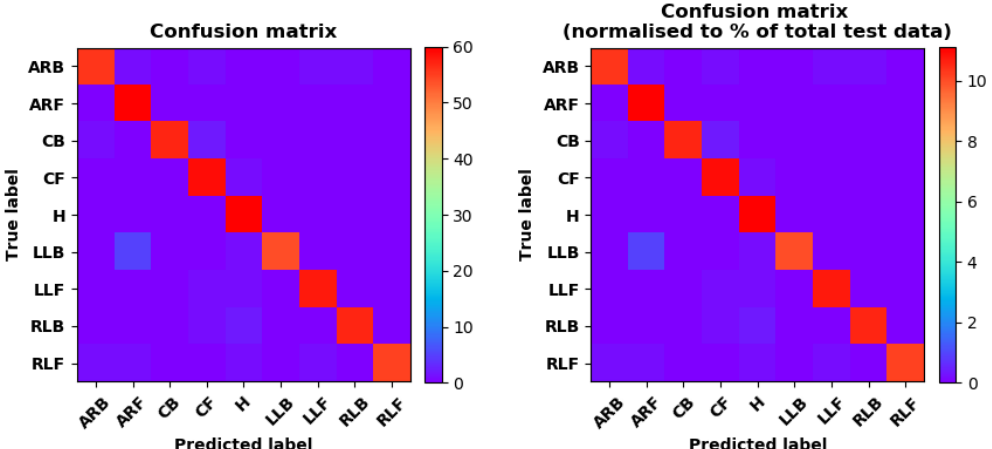
Figure 18. Left graph is the confusion matrix of classification test using the model trained by CNN network; right is the normalised confusion